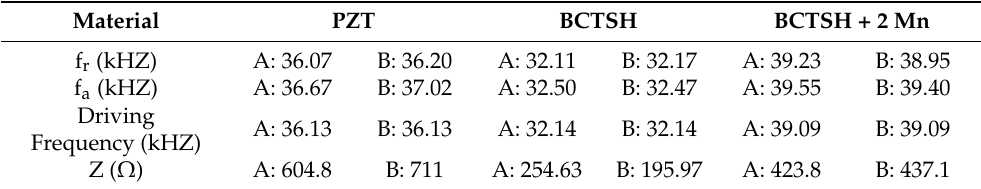
Table 2. The resonant frequencies and impedance of PZT, BCTSH and BCTSH + Mn piezoelectric motors using impedance